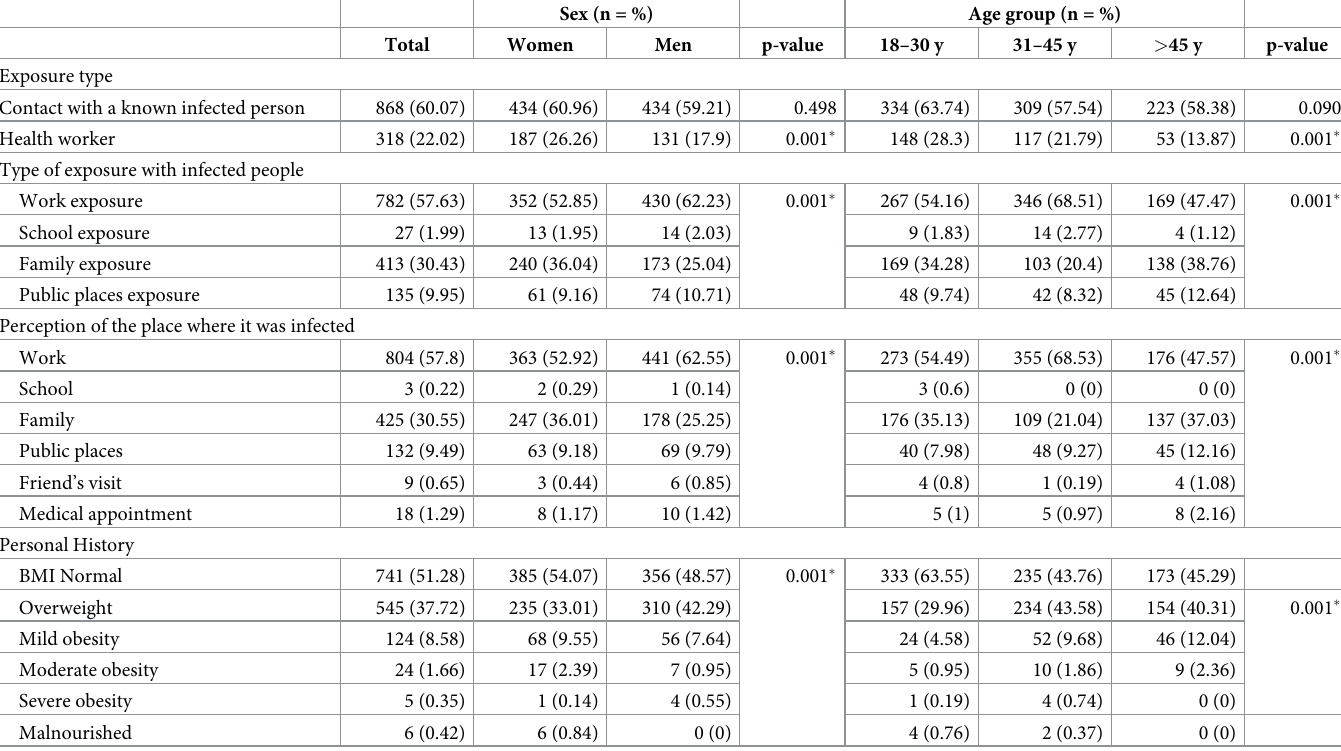
Table 3. Distribution of non-hospitalized patients infected with COVID-19 according to sex, age group, type of exposure and personal